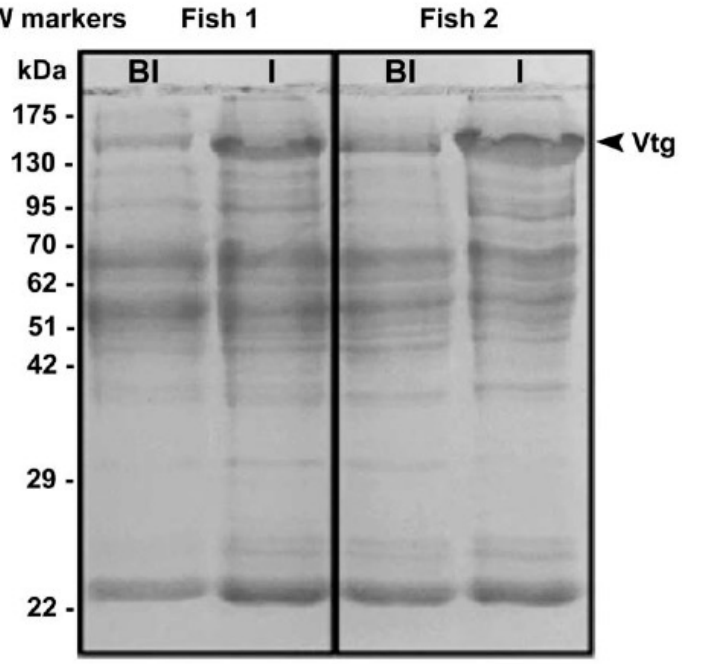
Figure 4. SDS-PAGE of two African bonytongue s, Heterotis niloticus , plasma samples before induction (BI) and after 17- β Estradiol treatment (I). One major band at 142 kDa molecular mass indicates the presence of Vtg in the treated plasmas.